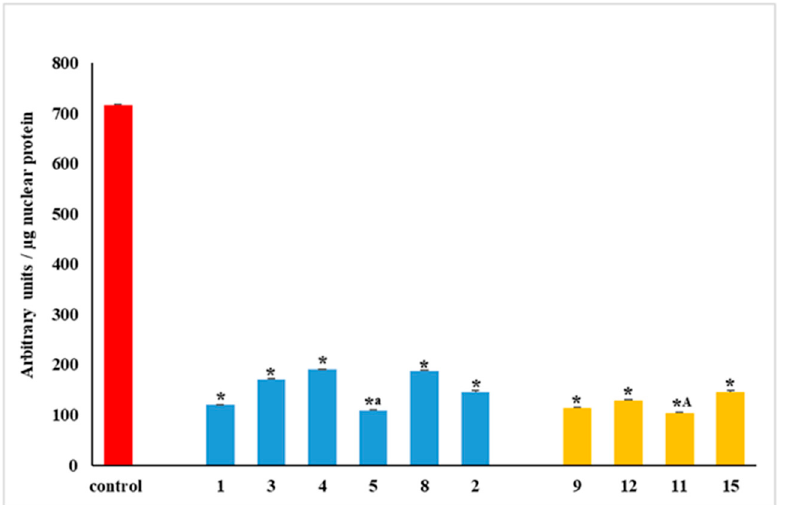
Figure 1. NF- κ B (p65 subunit) DNA binding capacity in nuclear extracts of HL60R cell line. The cells were treated for 24 h with compounds at the corresponding IC 50 values. Results are expressed as arbitrary units/ µ g protein of HL60R nuclear extracts and the mean ± SE of three independent observations, * p < 0.01 versus control; a p < 0.05: AO derivates versus precursor, A p < 0.05: LU derivates versus precursor (one-way ANOVA followed by Tukey’s test).